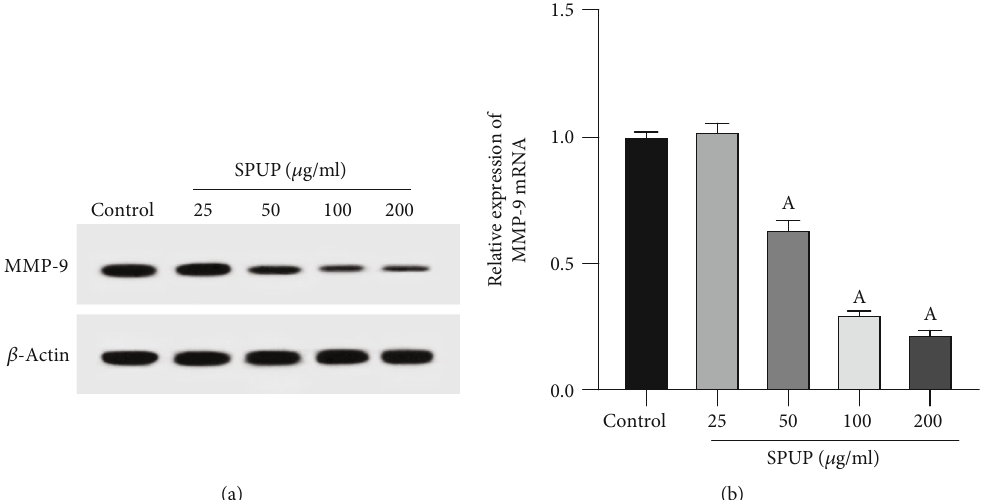
Figure 4: SPUP reduced both the expression of DU145 cells and that of migration-related protein MMP-9. Compared with the control group, A: <